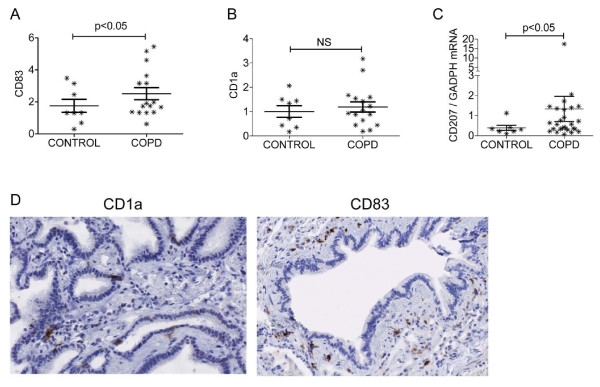
COPD tissue contains increased numbers of CD83+ cells and CD207 (Langerin) mRNA levels compared to control tissue. A) Quantitative total tissue expression of CD1a+ cells identified in whole tissue slides from 8 controls and 16 COPD subjects. The values on the vertical axis refer to the area of positive staining relative to the entire scanned tissue biopsy. Graph shows mean and SEM of all data points. NS = not significant. B) Quantitative total tissue expression of CD83+ cells in 8 controls and 16 COPD subjects. The values on the vertical axis refer to the area of positive staining relative to the entire scanned tissue biopsy. Graph shows mean and SEM of all data points. C) Increased CD207 mRNA expression in total lung tissue from patients with COPD (n = 27) compared with controls without COPD (n = 7). Relative CD207 mRNA expression is shown as the ratio of the number of transcripts for CD207 to the number of transcripts for the housekeeping gene GAPDH. Graph shows mean and SEM of all data points. D) Representative images demonstrating the dendritic cells with dark brown membranous positivity on CD1a (left panel) and CD83 (right panel) stainings. Right panel; 58-year old ex-smoker with FEV1 63% predicted. Left panel; 78-year old ex-smoker with FEV1 60% predicted.